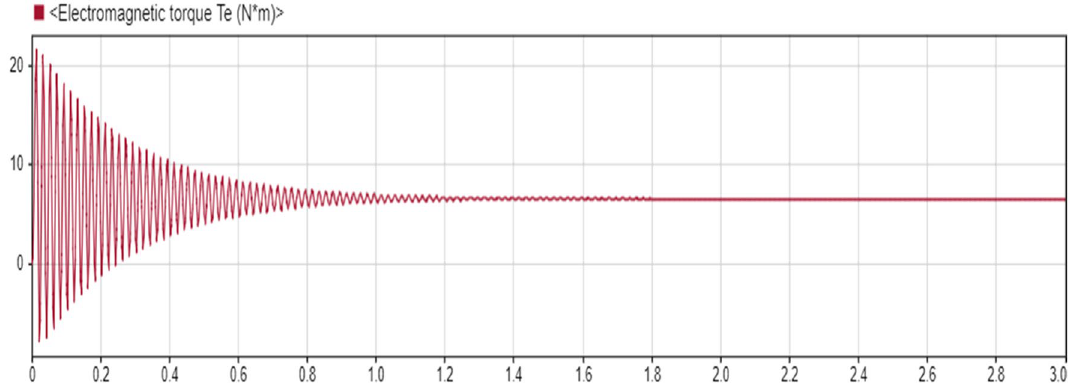
Fig. 5 Electromagnetic torque (Nm) versus time